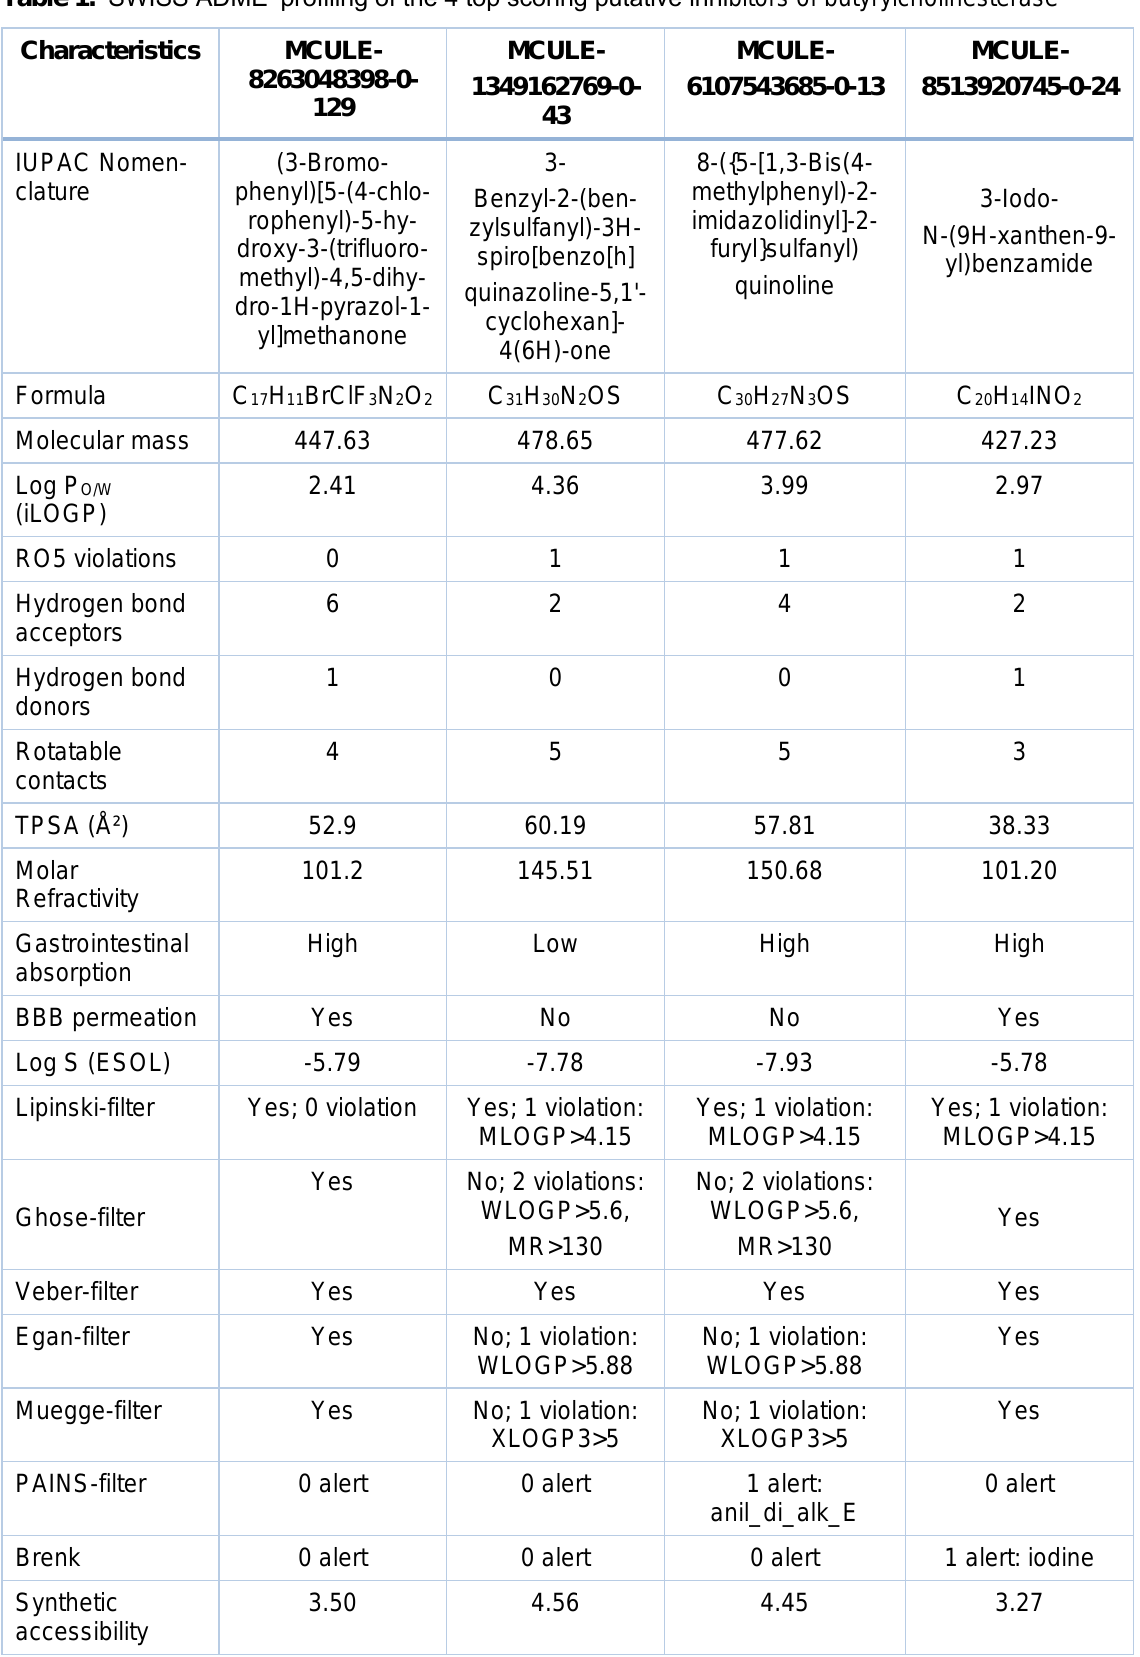
Table 1: ‘SWISS ADME’ profiling of the 4 top scoring putative inhibitors of butyrylcholinesterase